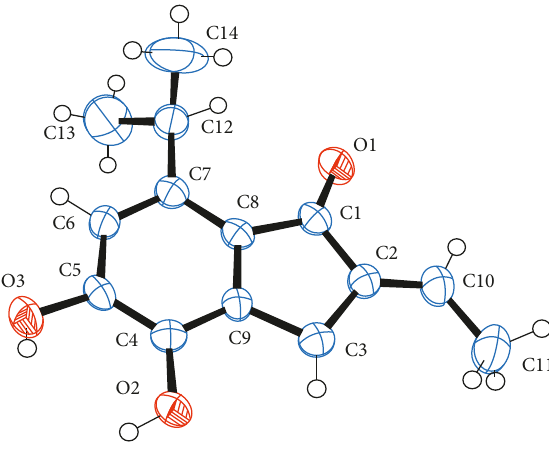
Figure 3: ORTEP drawing of compound 1 .